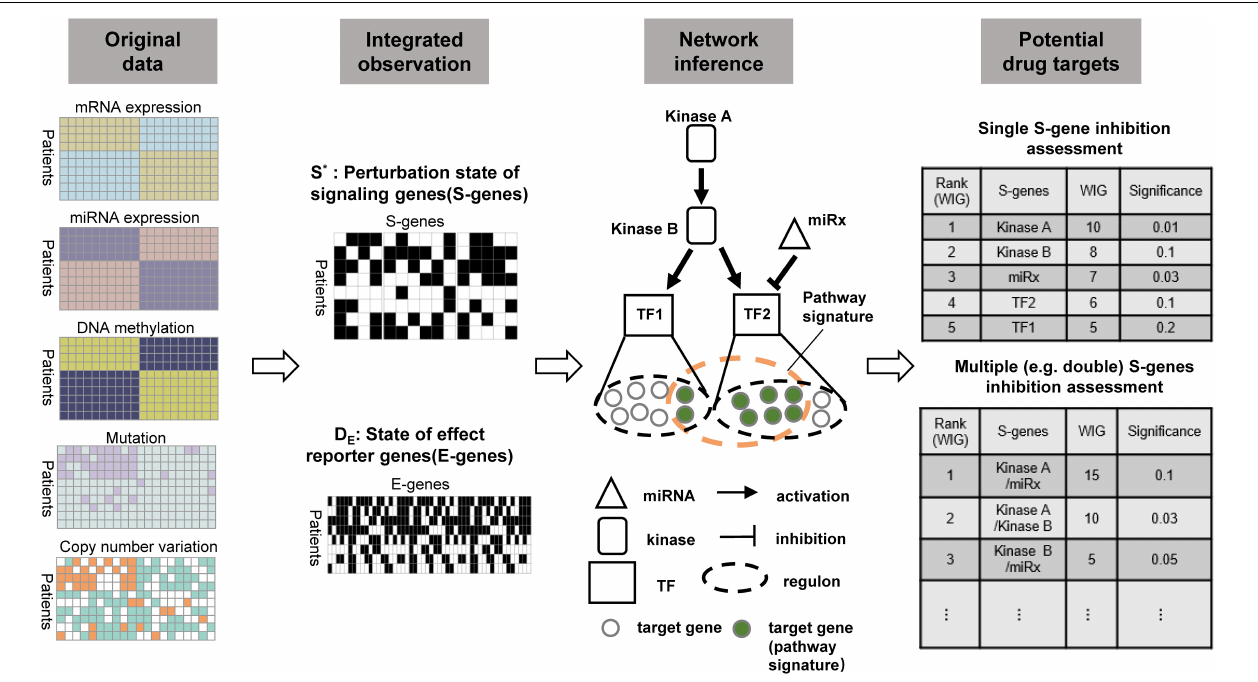
FIGURE 1 | The workflow of NEM-Tar for cancer regulatory network inference and potential drug targets prioritization. Observations of the states of S-genes and E-genes could be obtained after the preprocessing of multi-omics data. The signaling network regulating a specific cancer subtype will subsequently be inferred. Finally, based on quantification of the causal impact and specificity to downstream genes using WIG, potential drug targets could be prioritized for single and double